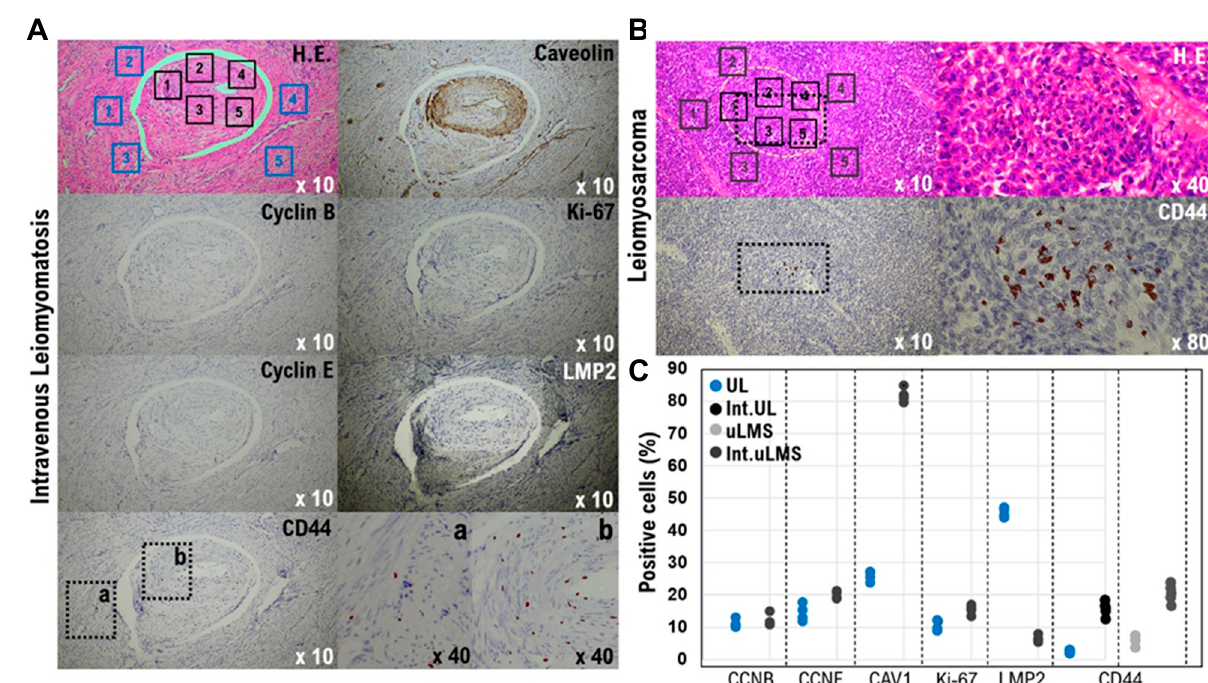
Figure 1. Differential expressions of factors cyclin B, cyclin E, caveolin 1, Ki-67, LMP2/b1i, and CD44 as potential biomarkers in intravenous leiomyomatosis and intravenous leiomyosarcoma. ( A ) Extensive intravascular growth of focal cellular smooth muscle is noted, forming worm-like plugs within veins. Focal hydropic change and components of endometrial glands are also observed. CD44-positive cells in the external tissue of intravenous are shown in the box a . CD44-positive cells in the internal tissue of intravenous are shown in the box b . ( B ) Intravenous leiomyosarcoma is shown in the upper right photograph. In uterine leiomyosarcoma, spindle-shaped tumor cells with round nuclei proliferate solidly. Compared with leiomyoma, uterine leiomyosarcoma shows increased nuclear density, nuclear hypertrophy, nuclear irregularities, and increased fission. ( C ) Immunohistochemistry of intravenous leiomyomatosis and intravenous leiomyosarcoma tissue sections was performed using appropriate monoclonal antibodies with standard procedures. The five tissue sites were randomly selected from intravenous leiomyomatosis’s internal and external tissues (i.e., normal uterine leiomyoma). As with uterine leiomyoma, the five tissue sites were randomly selected from the internal tissue of intravenous leiomyosarcoma. In a 40× field of view, the positive rates of the six factors were calculated in the five tissue sites. The positive rates at the sites of each tissue are shown in the scatter plot. Int.UL: Intravenous leiomyomatosis, Int.uLMS: Intravenous uterine leiomyosarcoma.